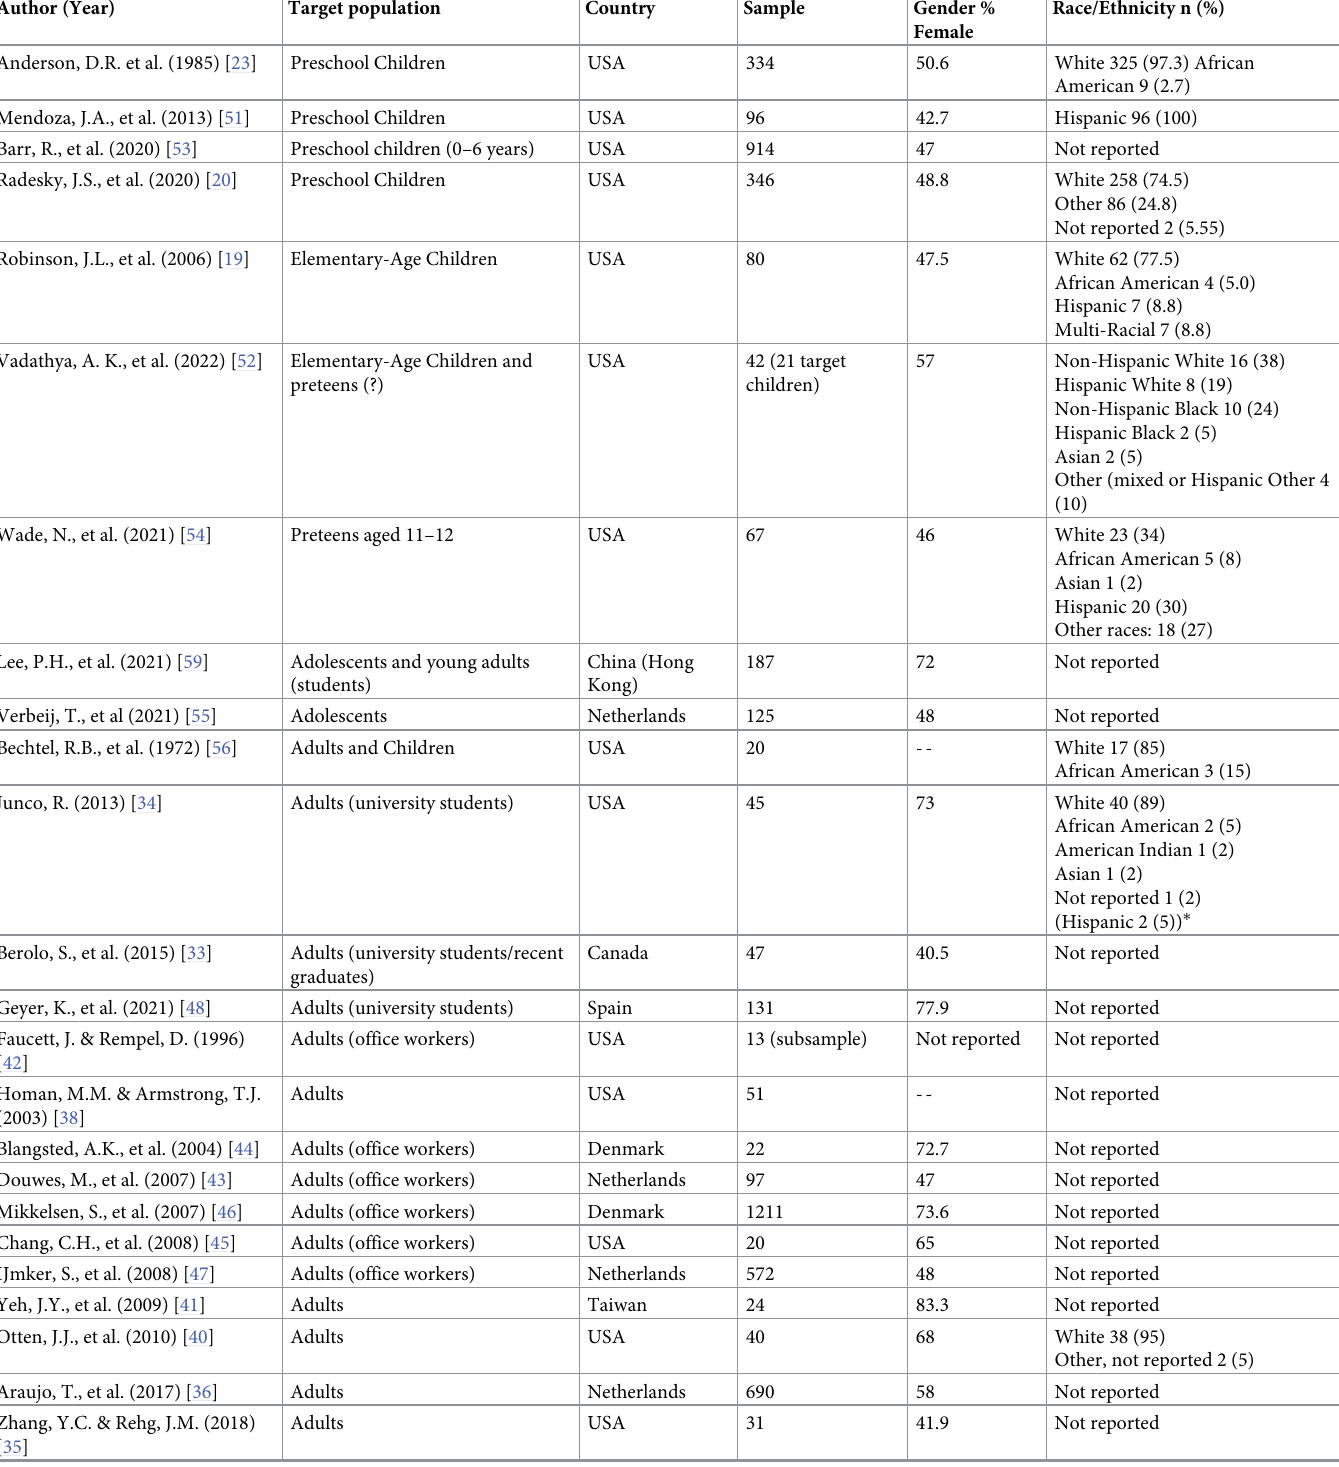
Table 1. Study participant